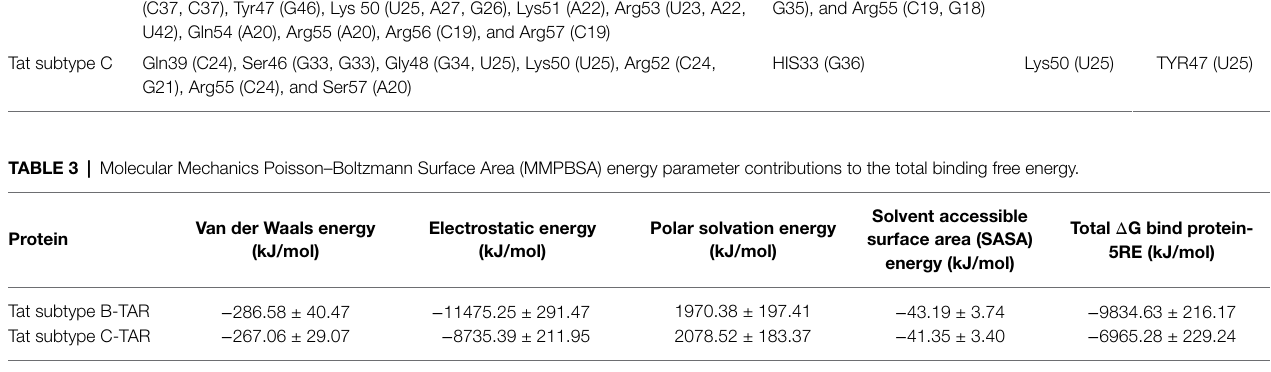
Salt bridge (nucleotides)